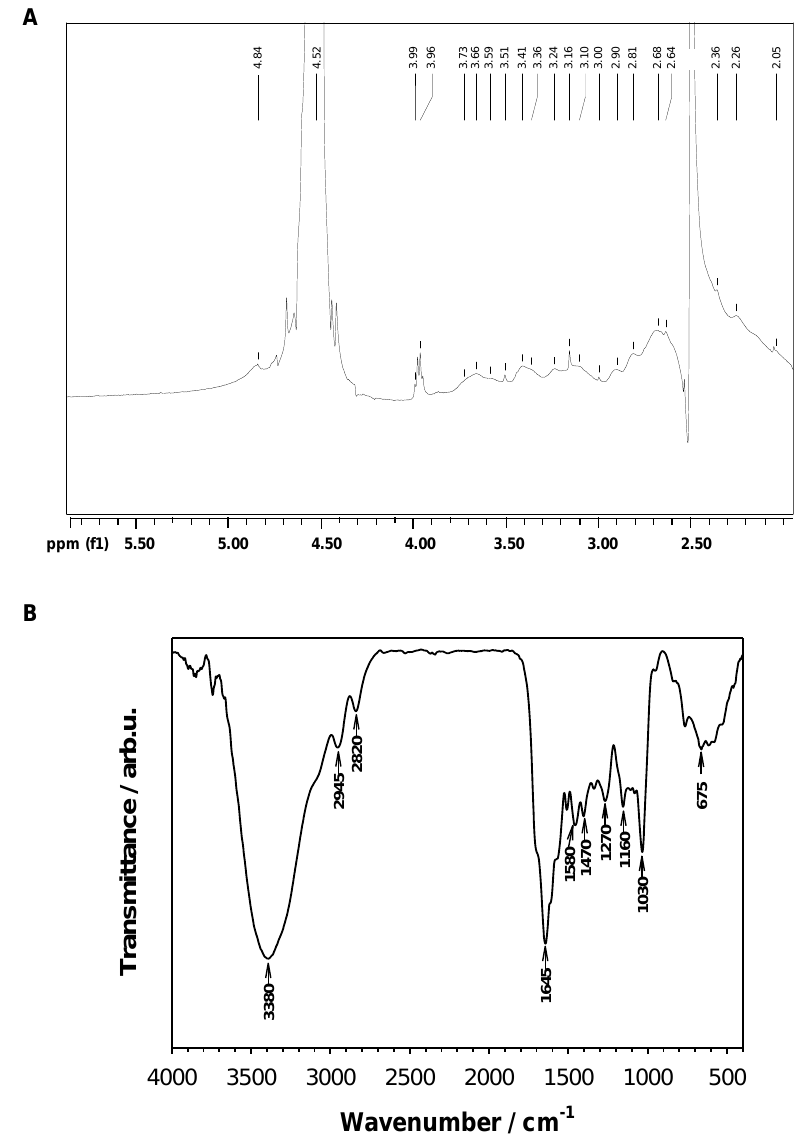
Figure 2. ( A ) 1 H NMR (D 2 O / DMSO-d 6 = 3:1 v / v , 500 MHz) spectrum of PEI- β CD- α CD-FA. ( B ) FTIR (KBr) spectrum of PEI- β CD- α CD-FA.